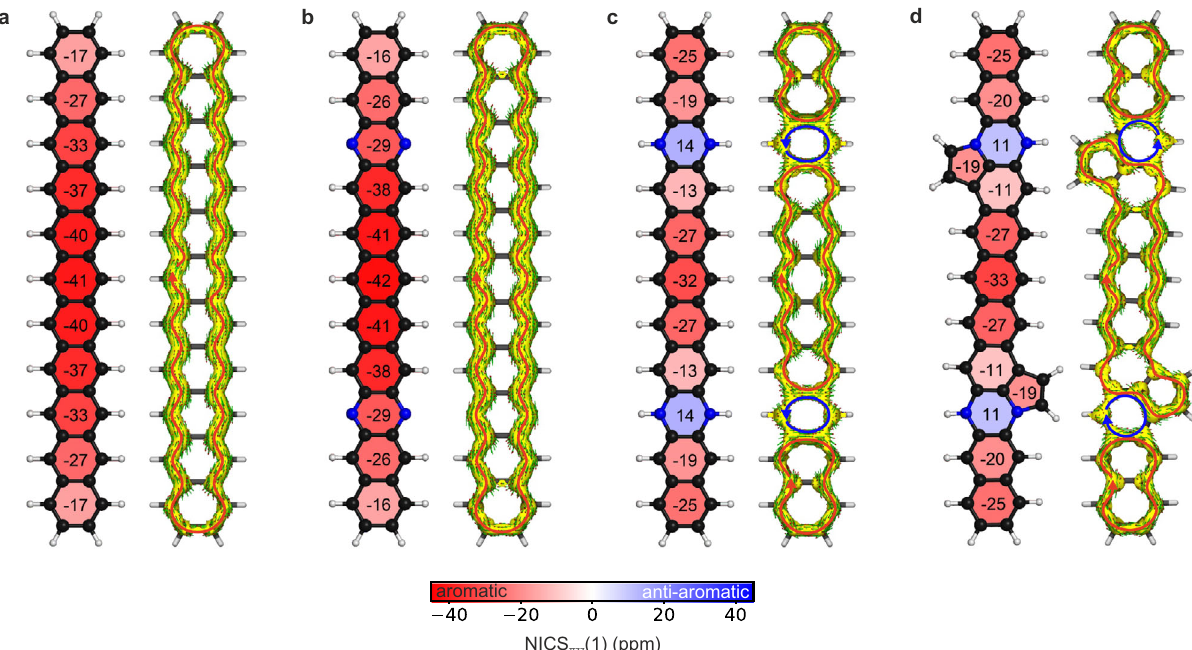
Fig. 5 Computational characterization of the aromaticity of the synthesized undecacene and tetraazaundecacenes. a NICS π zz (1) patterns (each cycle is represented by the NICS π zz (1) evaluated at the center) and π -ACID plot (magnetic fi eld is applied perpendicular to the plane of the system, pointing toward the reader; red arrows indicate aromatic diatropic and blue arrows anti-aromatic paratropic ring current) for the closed-shell solution of the undecacene 4 . b NICS π zz (1) pattern and π -ACID plot for closed-shell solution of the tetraazaundecacene 3 . c NICS π zz (1) pattern and π -ACID plot for the hydrogenated tetraazaundecacene 1 . d NICS π zz (1) pattern and π -ACID plot for the hydrogenated tetraazaundecacene with edge-fused fi ve-membered rings 2 . All π -ACID plots are showing the isosurface at isovalue 0.05